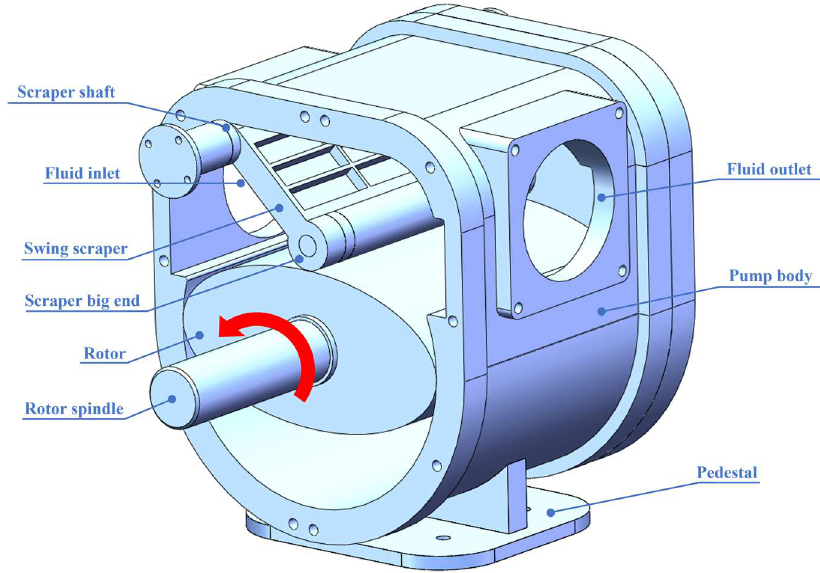
Figure 1. The structure of the ERSP.